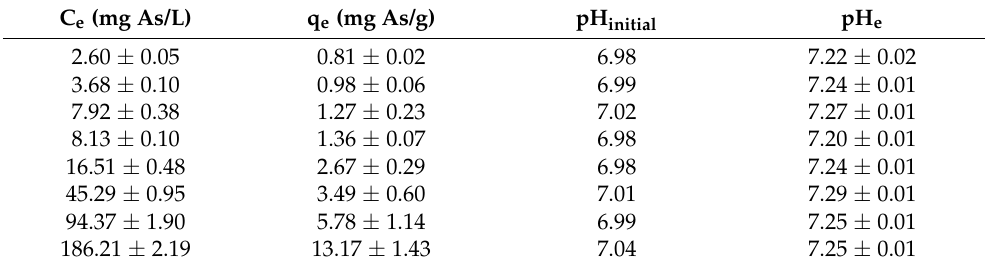
Table 3. Arsenic adsorption onto ChM hydrogel beads at equilibrium at 25 ◦ C and initial pH = 7.0. C e (mg As/L) q e (mg As/g) pH initial